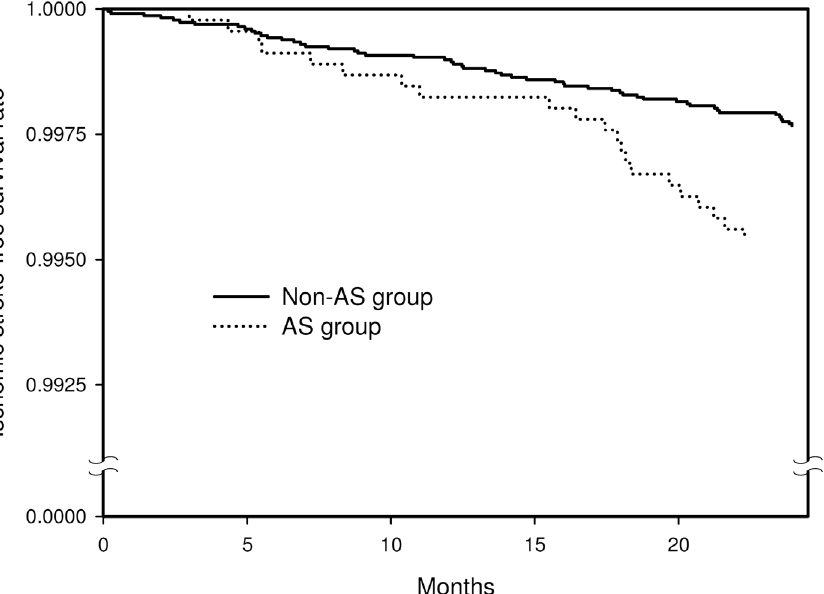
Figure 1. Two-year ischemic stroke-free survival rates for the ankylosing spondylitis (AS) group (dotted line) and non-AS group (solid line).